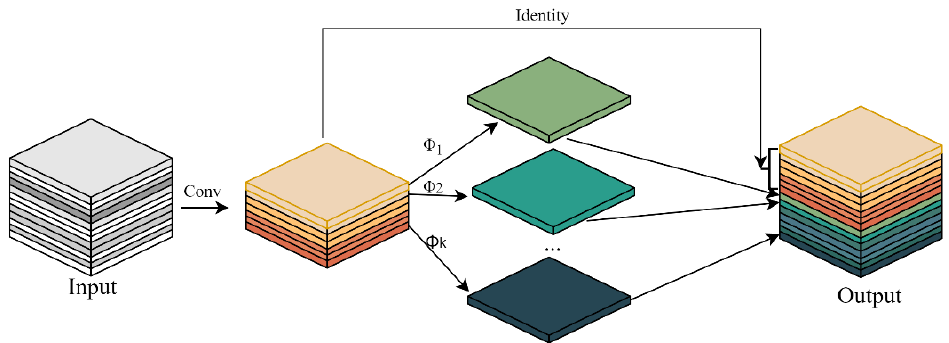
Figure 2. The structure of the Ghost module.